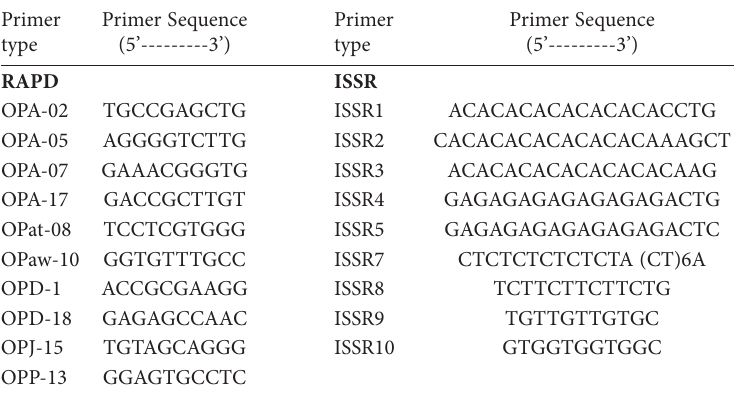
Table 1. The applied RAPD and ISSR